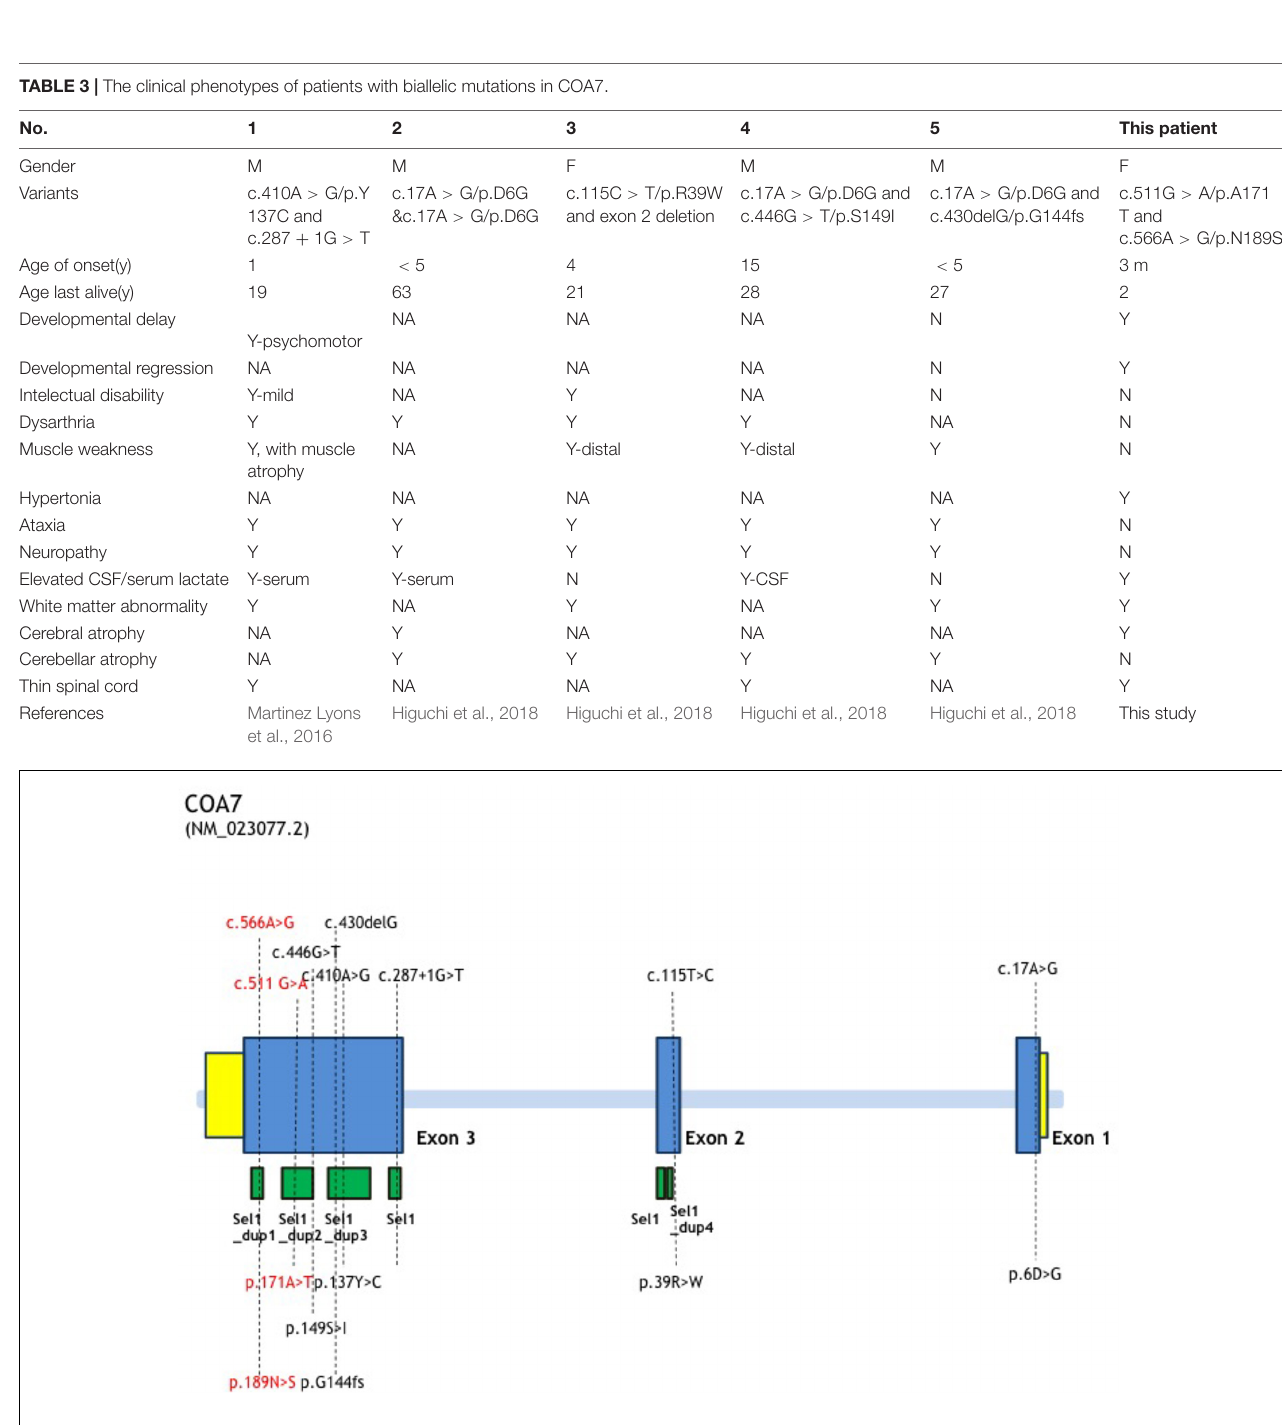
FIGURE 3 | COA7 mutation status, gene structure of affected amino acid residues. Gene structure of COA7 mutations in 5 patients. The newly found mutations of this study are shown in red.